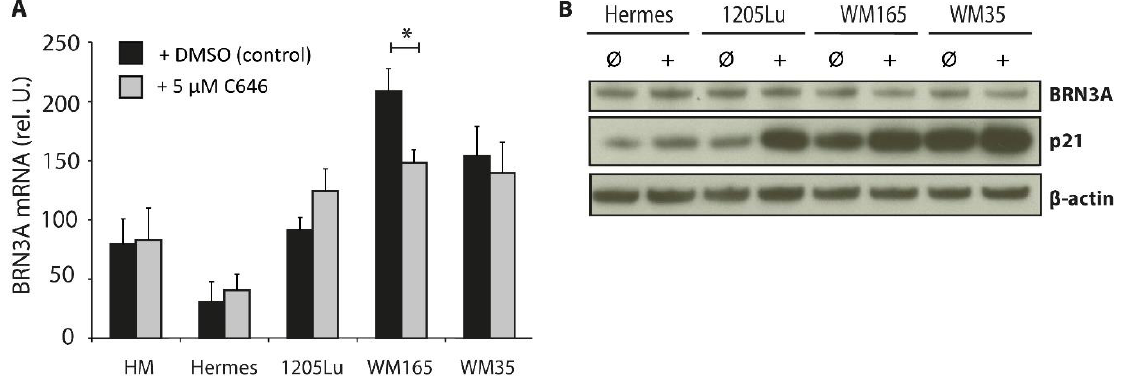
Figure 2. BRNA expression levels after HAT inhibition. ( A ) Relative BRN3A gene expression in HM, Hermes, and melanoma cell lines (1205Lu, WM165, and WM35). Cells were incubated with 5 µM C646 or DMSO (control) for 6 h, n = 3; *: p < 0.05 vs. corresponding DMSO control. ( B ) Protein expression of BRN3A and p21 after treatment with 5 µM C646 (+) or DMSO (control, Ø ) for 24 h; one representative immunoblot is shown.